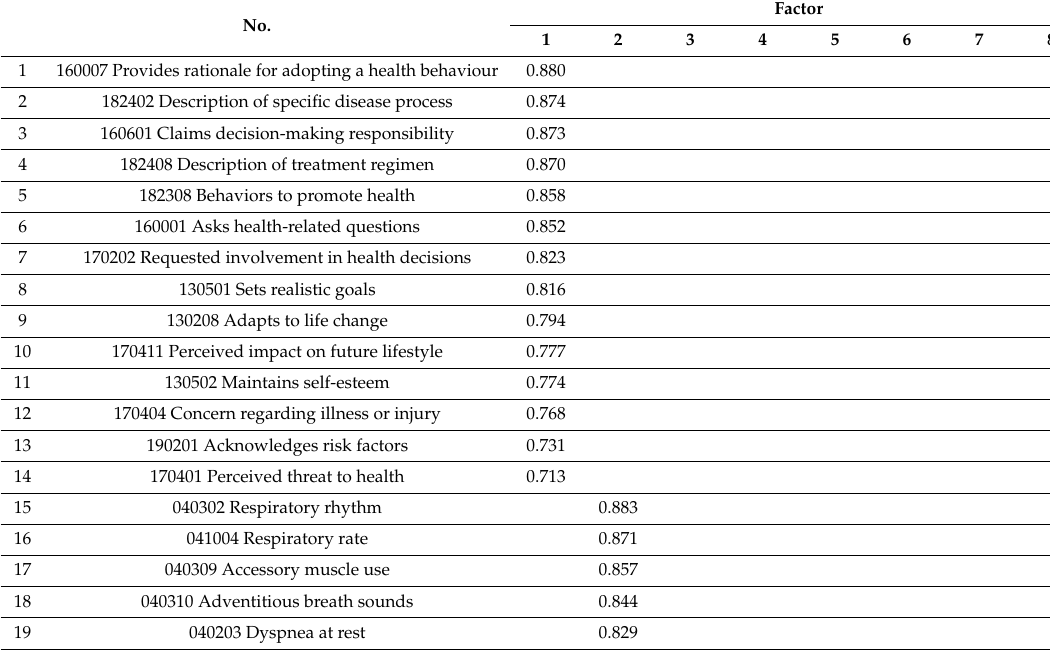
Table 2. Structure matrix of the rotated solution 46-item version